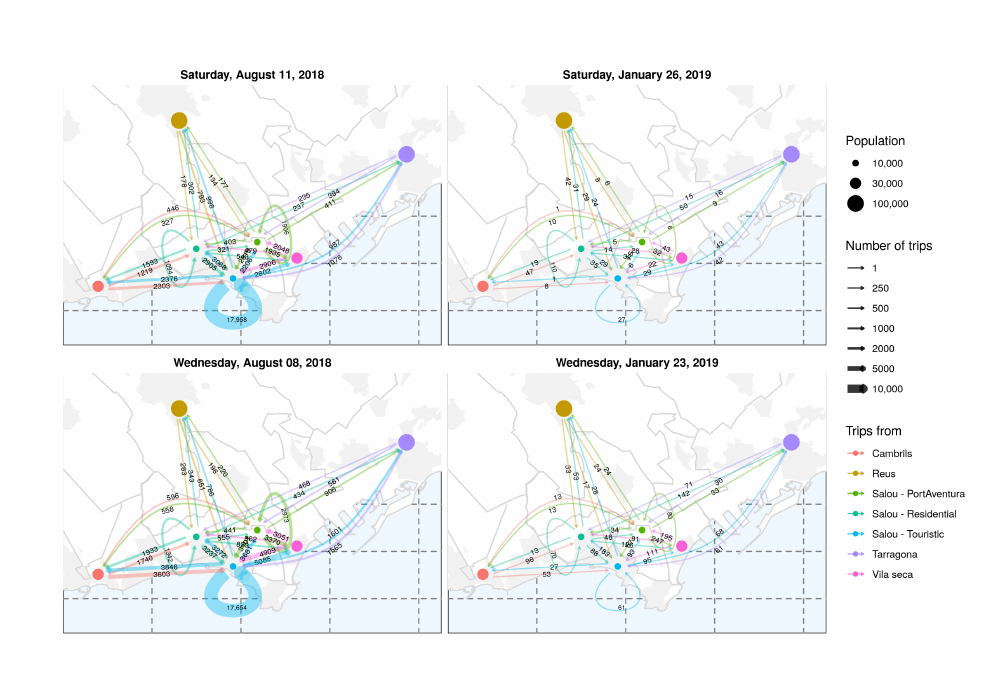
Figure 6. Flow maps of the intra-urban and inter-urban mobility in Salou of the international